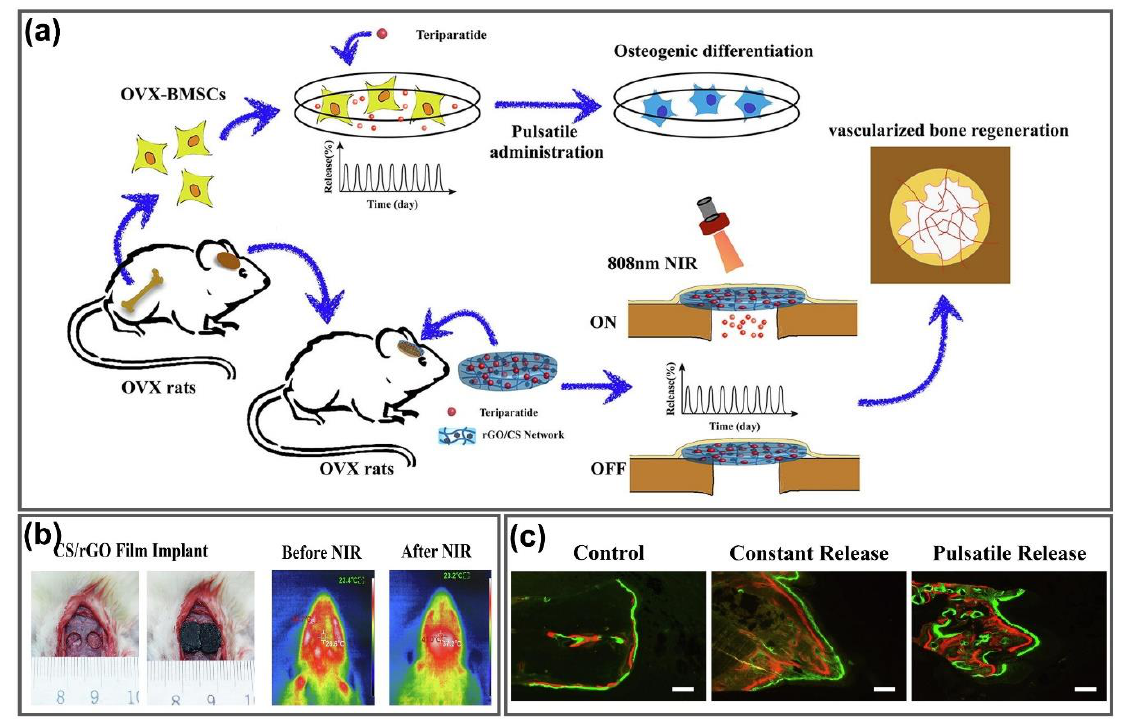
Figure 10. GGels for tissue repair and bone regeneration. ( a ) Schematic diagram of photothermally triggered biomimetic drug delivery of teriparatide via rGO loaded CS hydrogel for osteoporotic bone regeneration. ( b ) Implant of CS/rGO hydrogel films into calvarial defect models of osteoporotic rats and photothermal images before and after low-power NIR irradiation. ( c ) Bone formation after 6 weeks treatment confirmed by the sequential fluorescent labeling of alizarin red (red) and calcein (green). Adapted with permission from [149] .